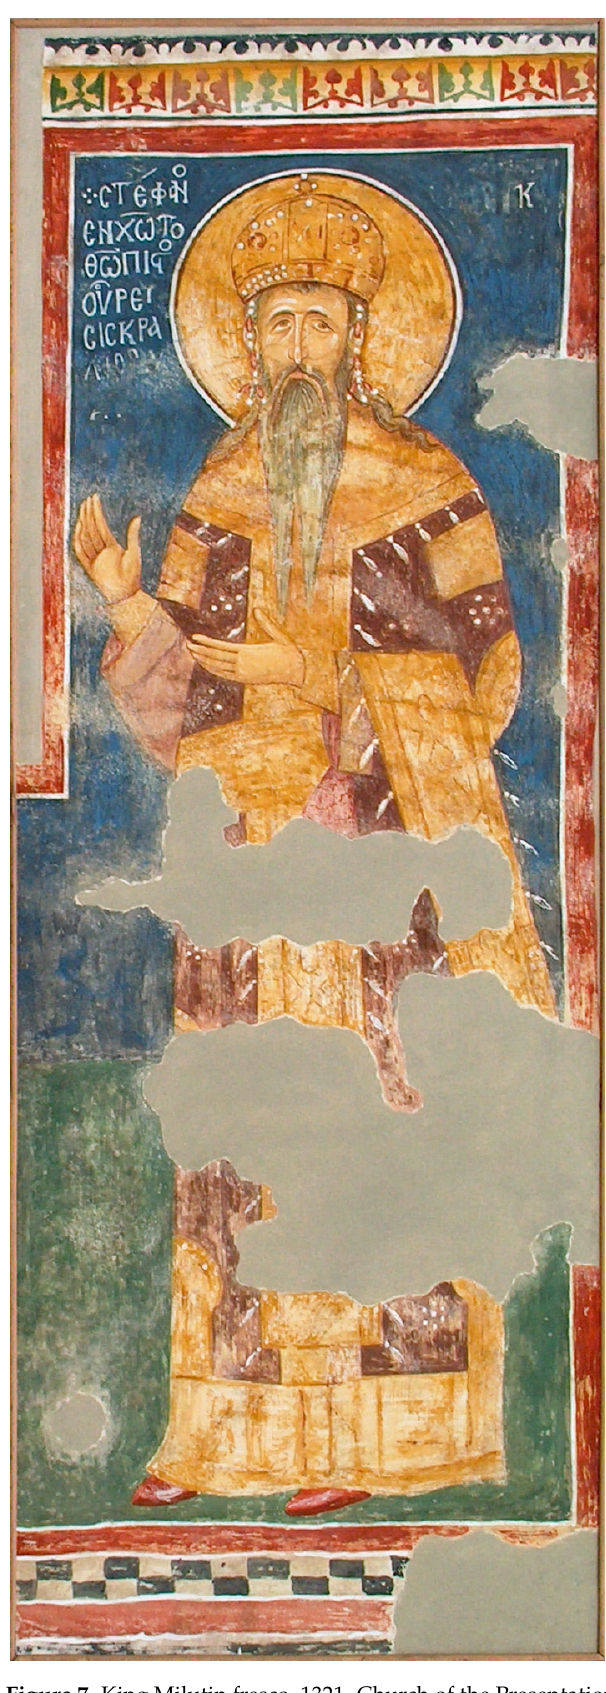
Figure 7. King Milutin fresco, 1321. Church of the Presentation of the Virgin, Monastery of Chilandar, southwest corner of the nave. Courtesy Gallery of Frescoes,